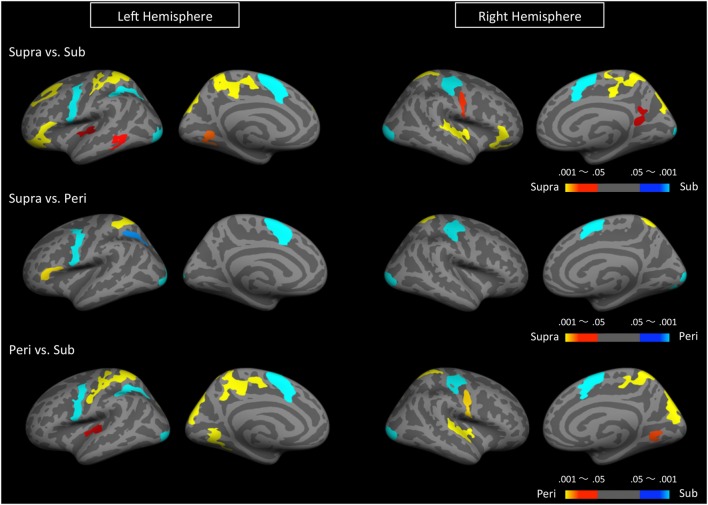
Significantly activated clusters in sub-, peri-, and supra-second timing. The color scales indicate the cluster-wise corrected P-values.